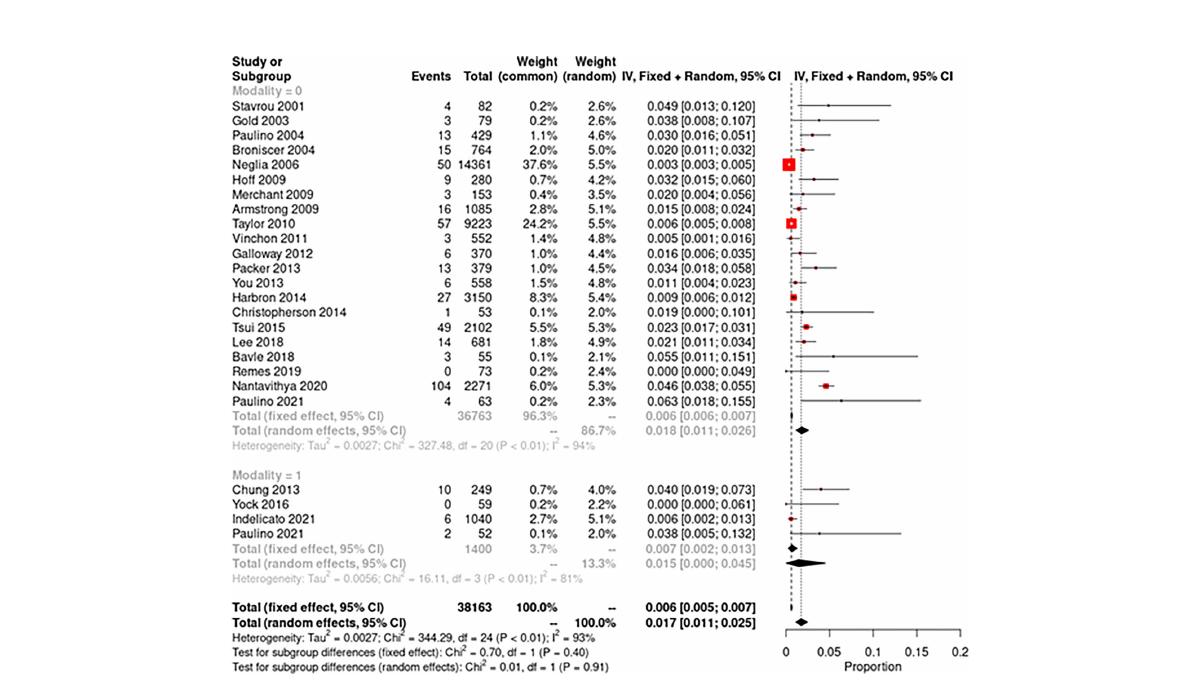
FIGURE 2 Forest plot demonstrating pooled analysis of secondary malignant neoplasms with photons (modality = 0) and protons (modality = 1).